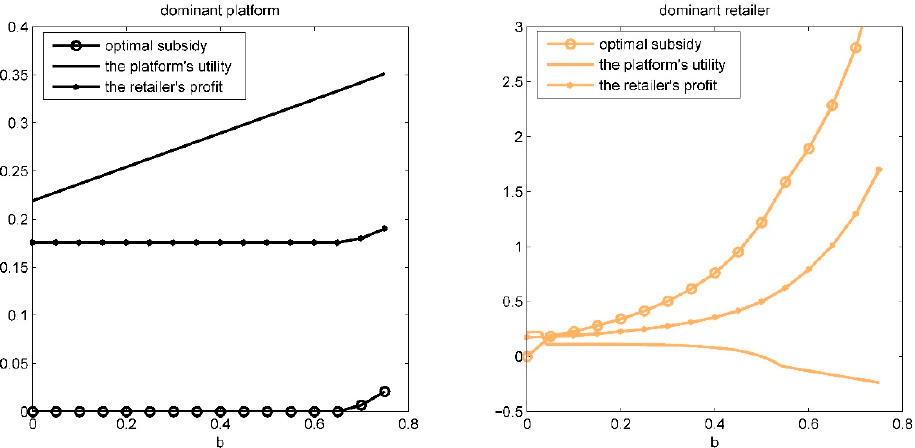
Figure 4. Optimal sales subsidy, the platform’s utility, and the retailer’s profit under different power structures with the change of b .